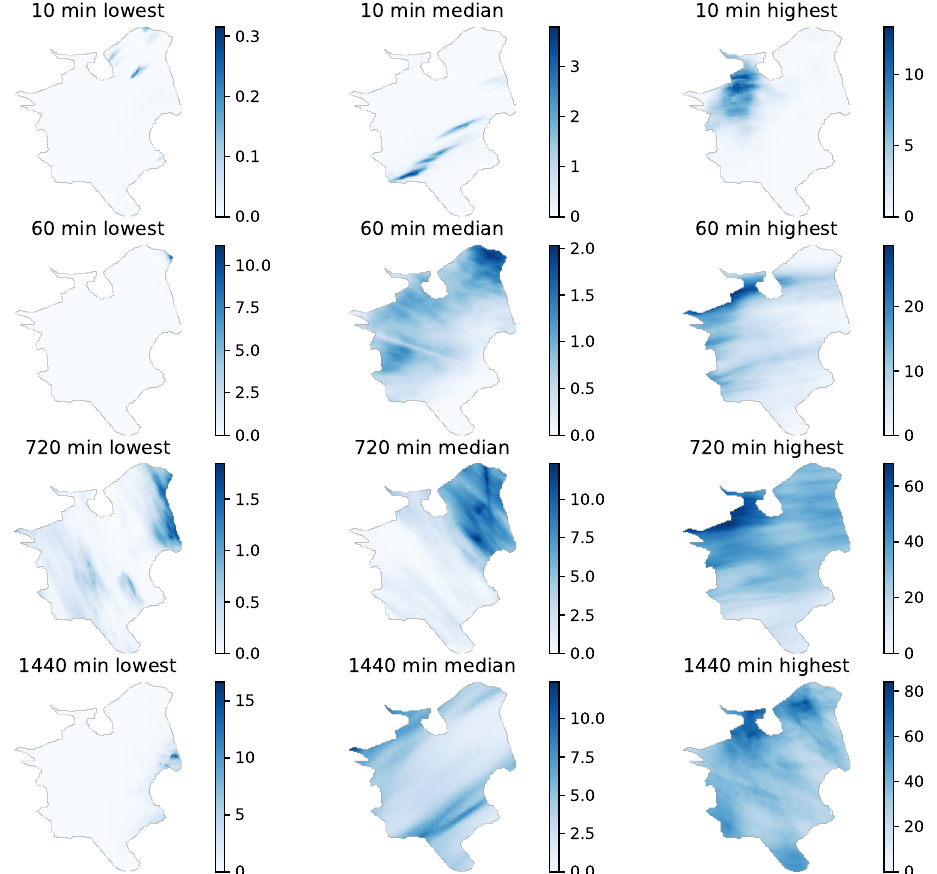
Figure 3. Examples of the spatial variability of accumulated rainfall depths for the duration-specific storms added to the final rainfall catalogs. The unit for the colorbars are in mm rainfall depth. Lowest, median, and highest refer to the rank of the domain mean rainfall